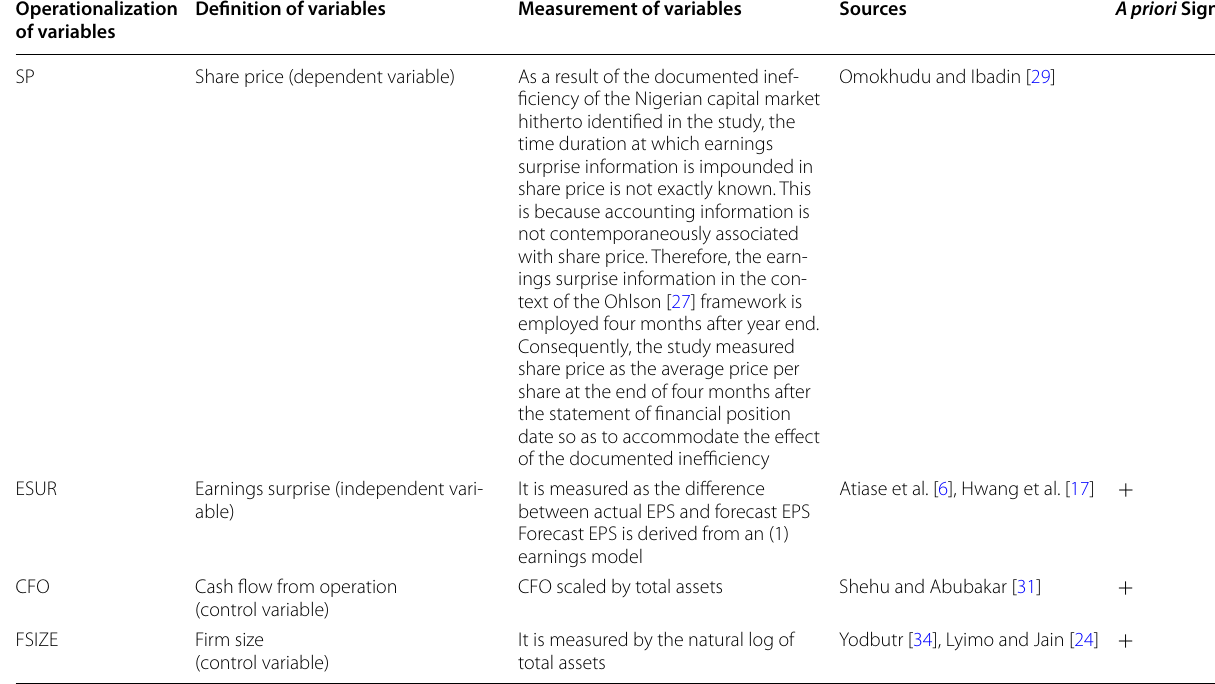
Table 1 Measurement and operationalization of variables Operationalization of